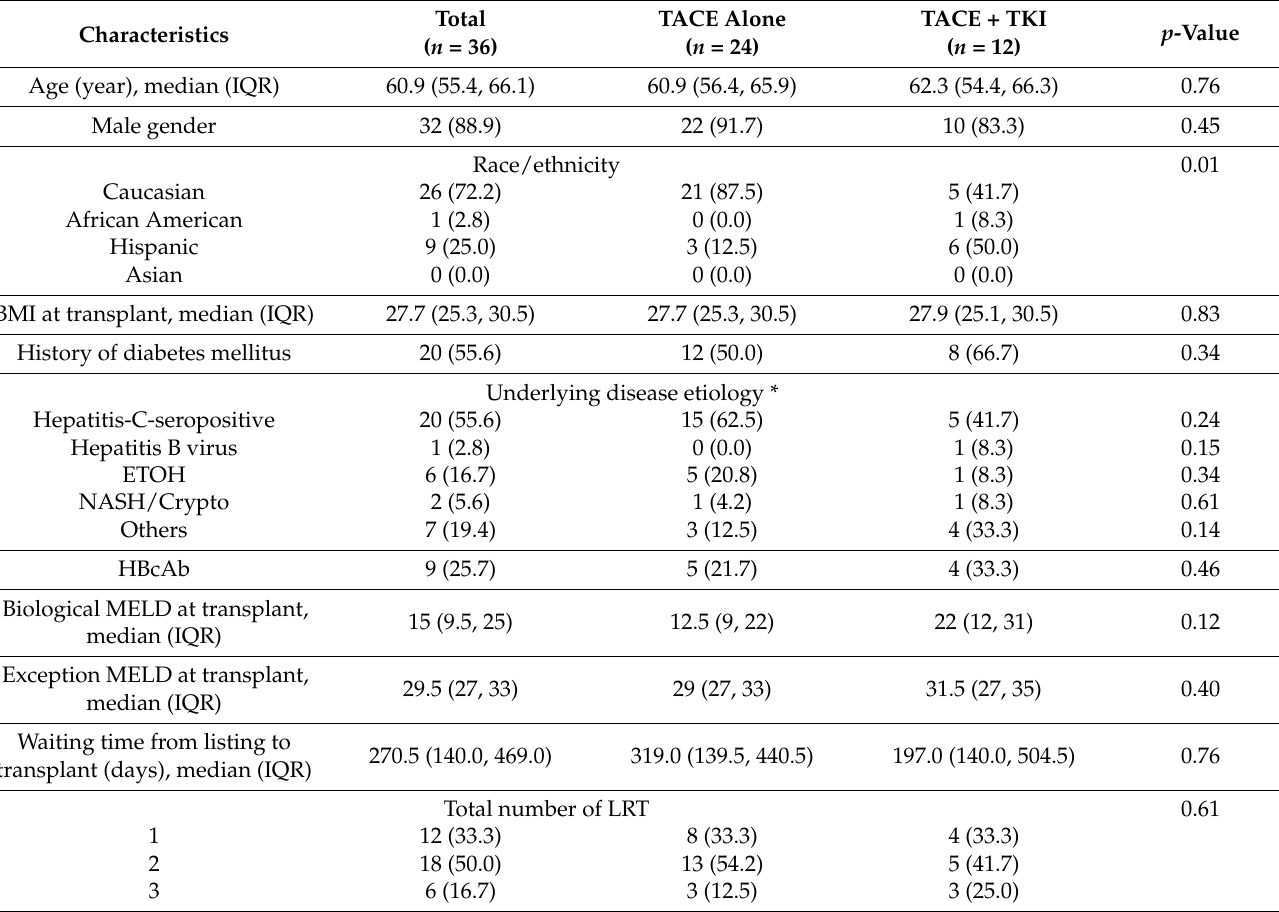
Table 3. Patient demographics of the beyond Milan group only, stratified by TACE